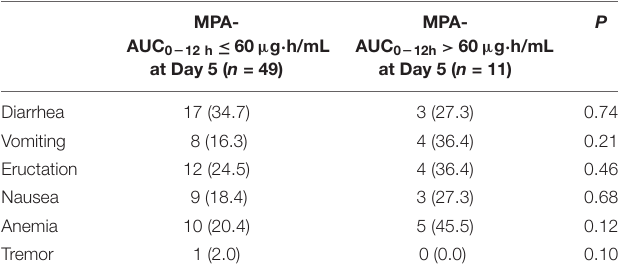
TABLE 5 | Comparison of incidences of AEs in different MPA-AUC 0 − 12 h